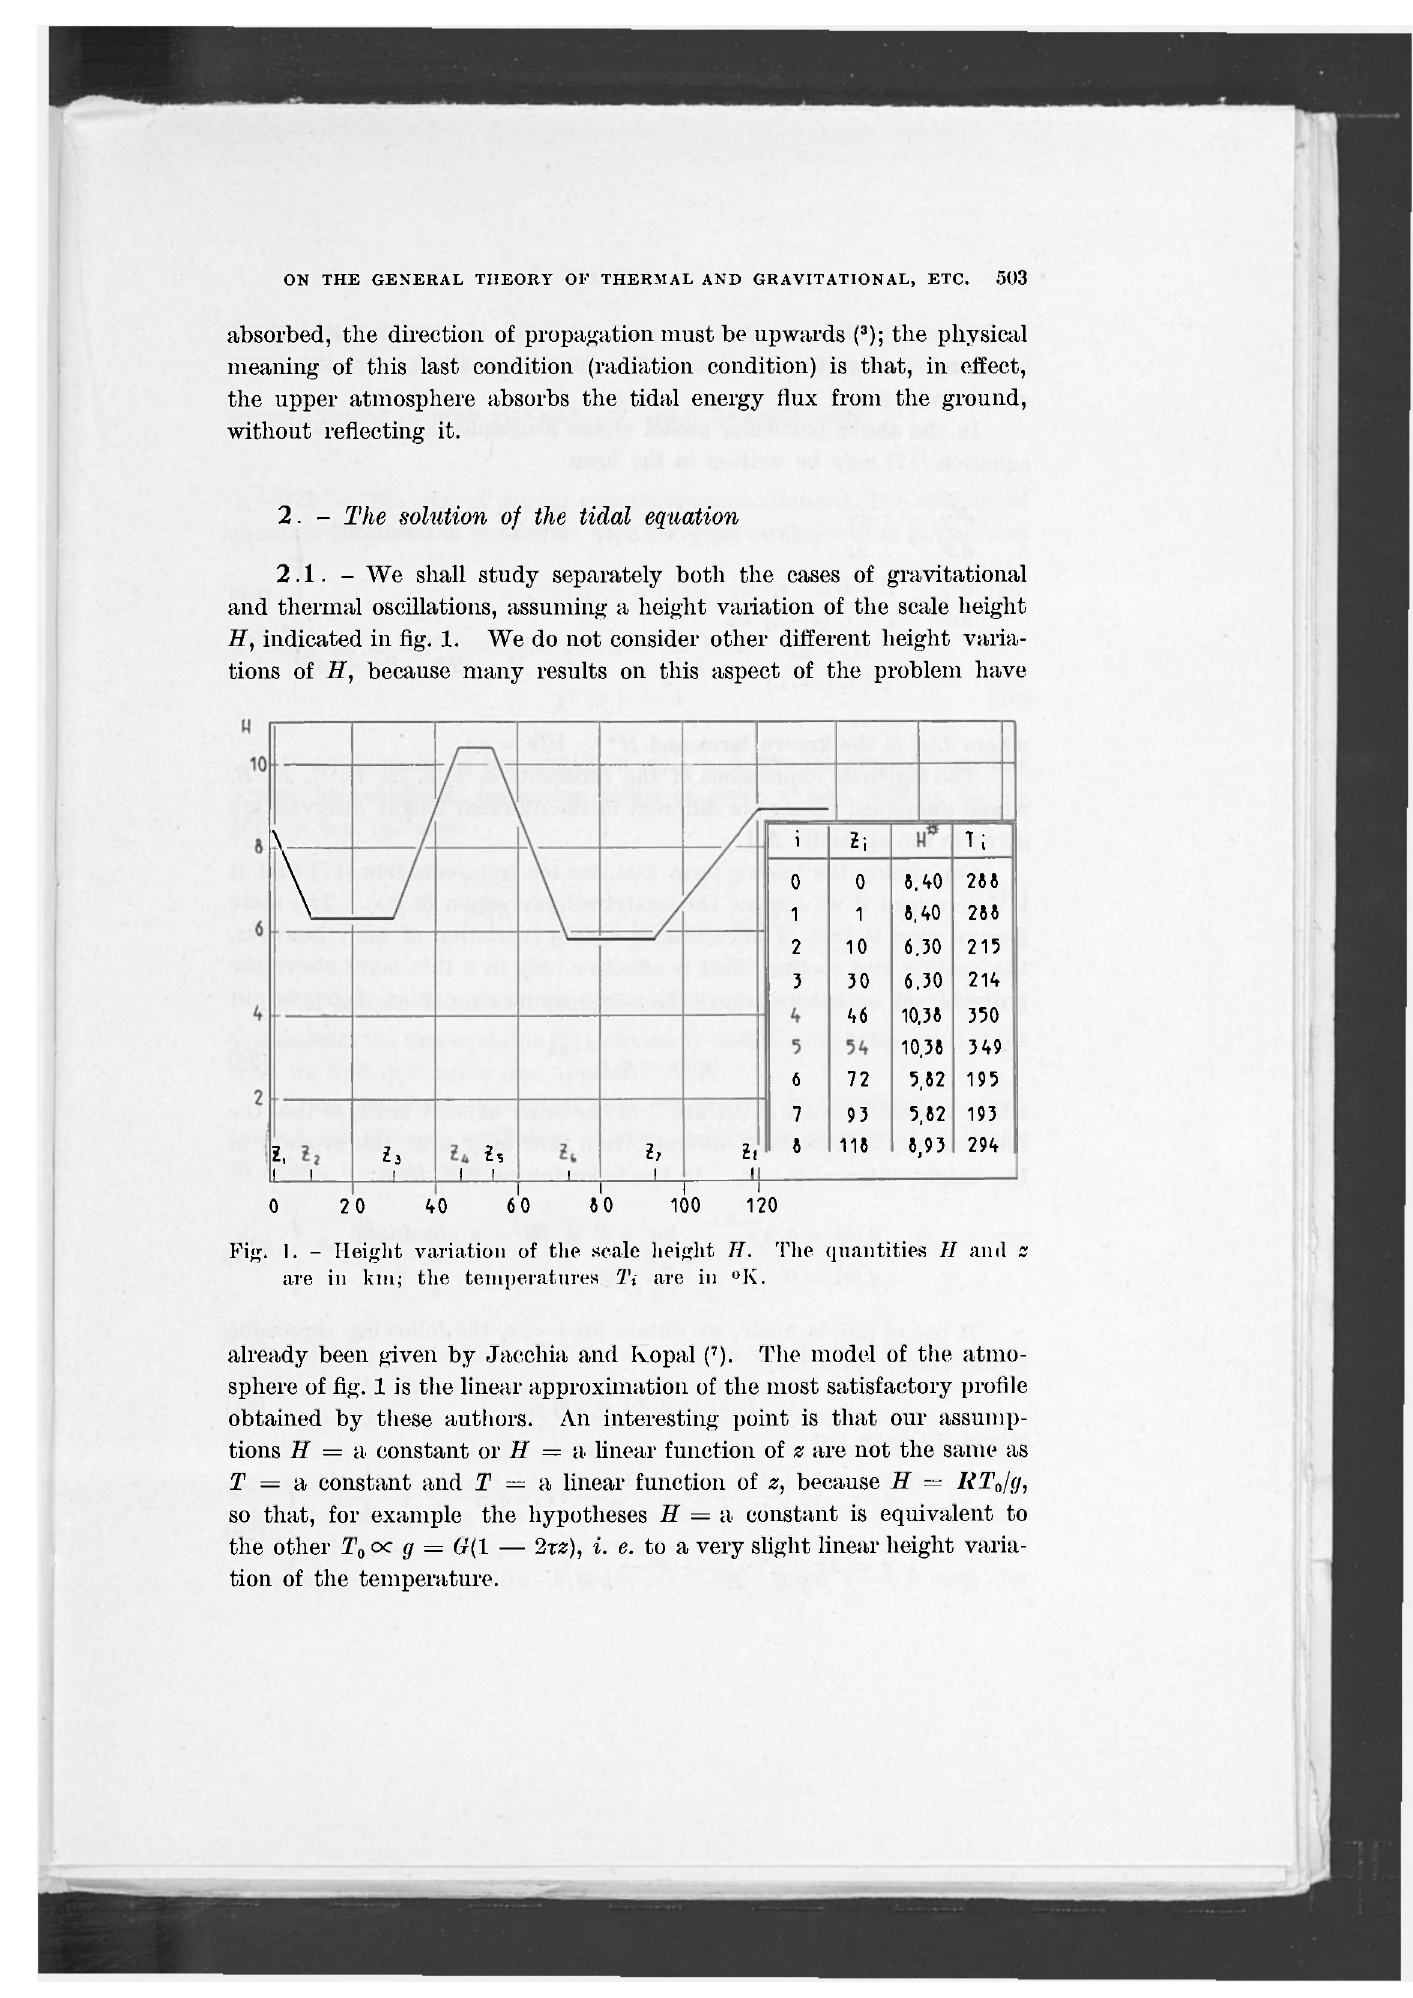
Fig. 1. - Height variation of the scale heiglit II. The qùantities II and z are in km; the temperatures Ti are in